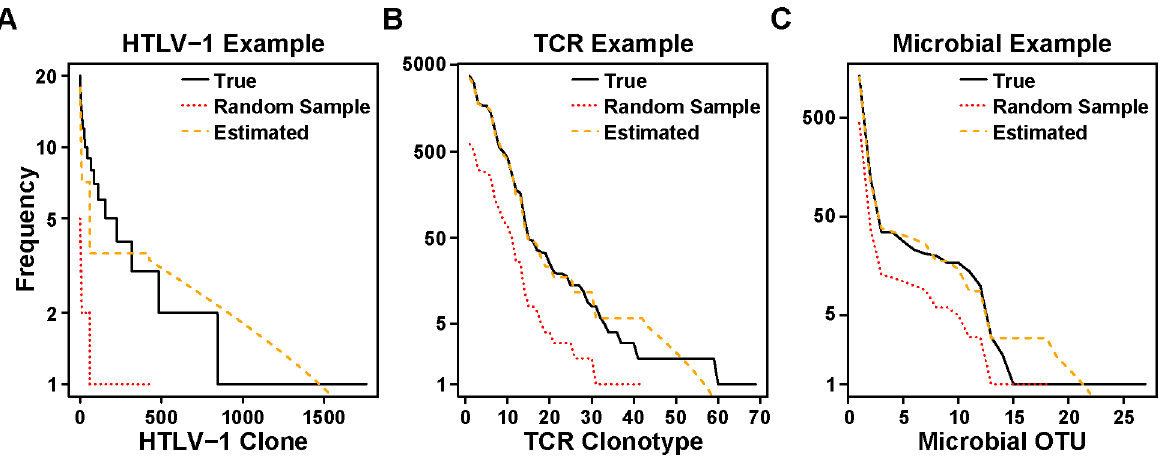
Figure 7. Validation of DivE distribution generation algorithm. The DivE distribution generation algorithm (Figure 2) was applied to random samples (red dashed) of observed data (black solid). Accuracy was evaluated by comparing the estimated distribution (orange dashed) to the true distribution of the full observed data (black). Examples for HTLV-1 A , TCR B and microbial datasets C are shown.